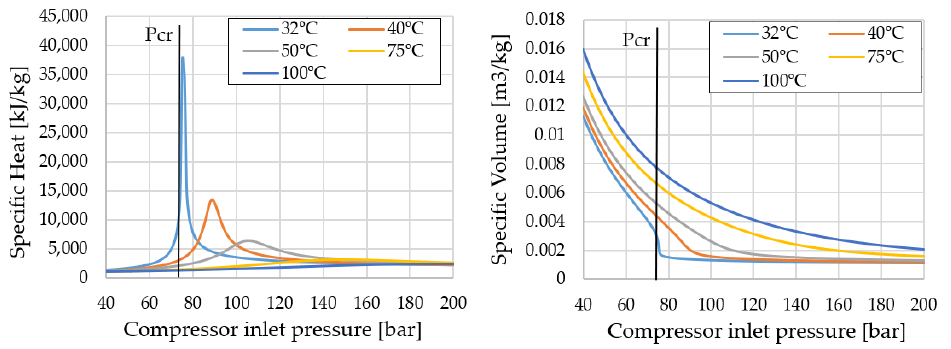
Figure 2. Summary of the five candidates supercritical CO 2 cycles studied.